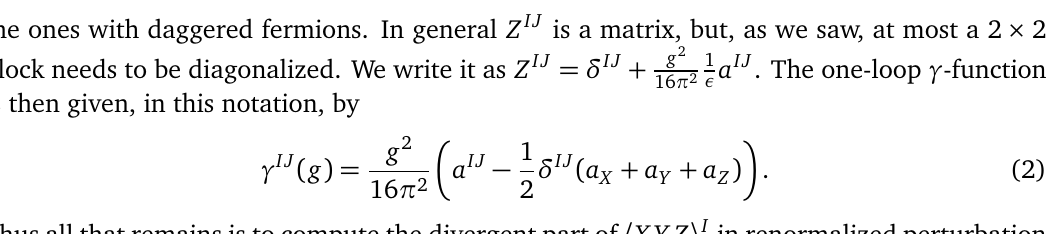
Figure 1: Diagrams giving the divergent part of the “ P × I ” vertex in the fully chiral (no dotted indices)